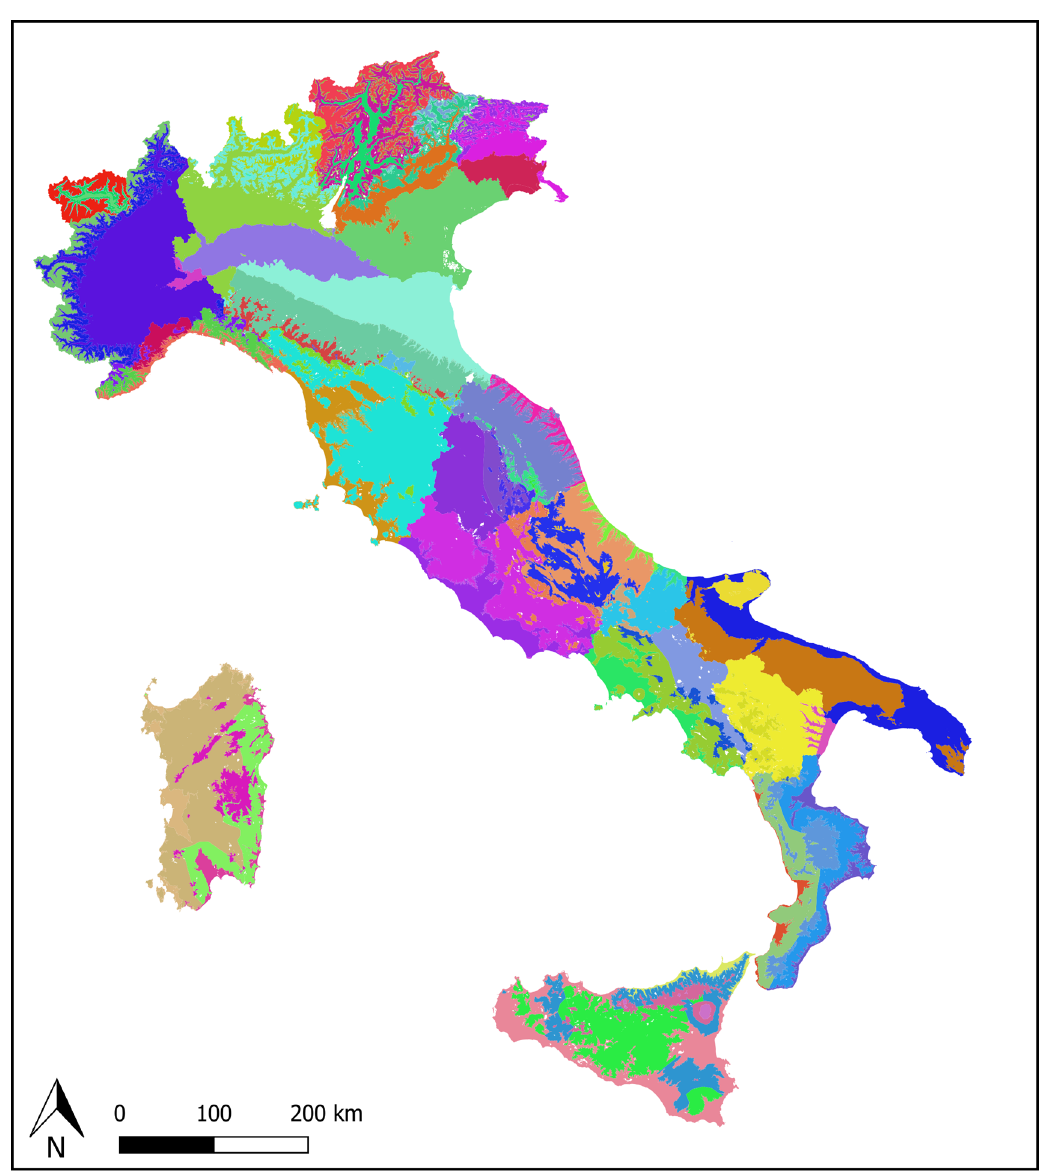
Figure 2. The 97 OGUs in which Italy was divided by combining administrative and ecoregional subdivisions. Table 2. Number of ecoregions for each Administrative region in Italy, and percentages of their surface areas in each region. The ecoregions are: Alpine (A), Subalpine (A1), Oromediterranean (B), Montane (C), Dry Submediterranean (D), Padanian (E), Humid Submediterranean (F), Humid Mediterranean (G), Dry Mediterranean (H).